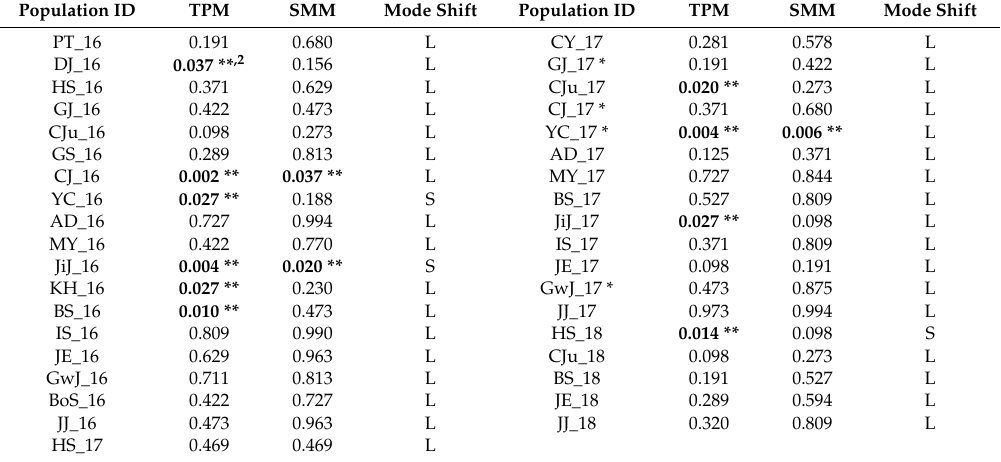
Table 2. Wilcoxon signed-rank test for mutation-drift equilibrium estimated based on eight microsatellite loci.